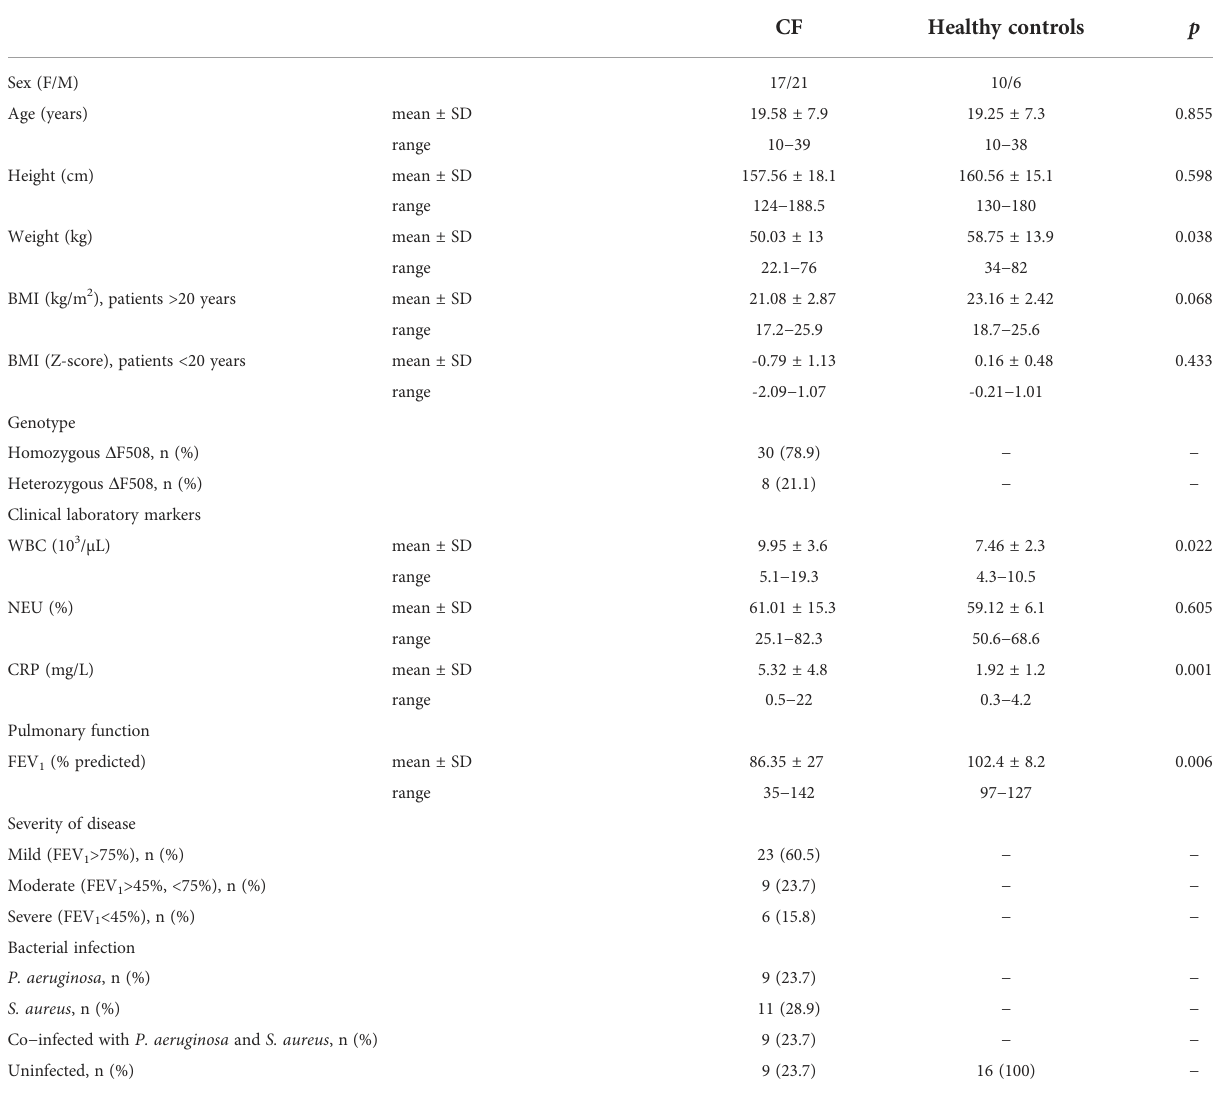
TABLE 1 Basic characteristics of study participants*.